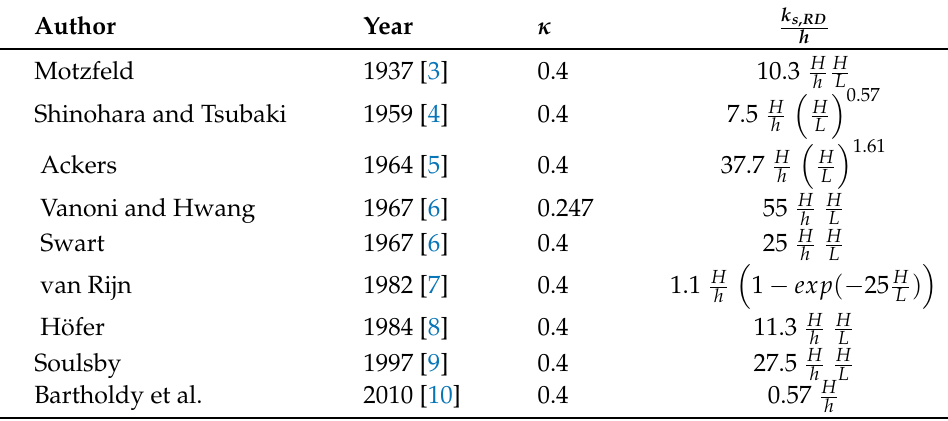
Table 1. Approaches via the logarithmic velocity profile (Equation